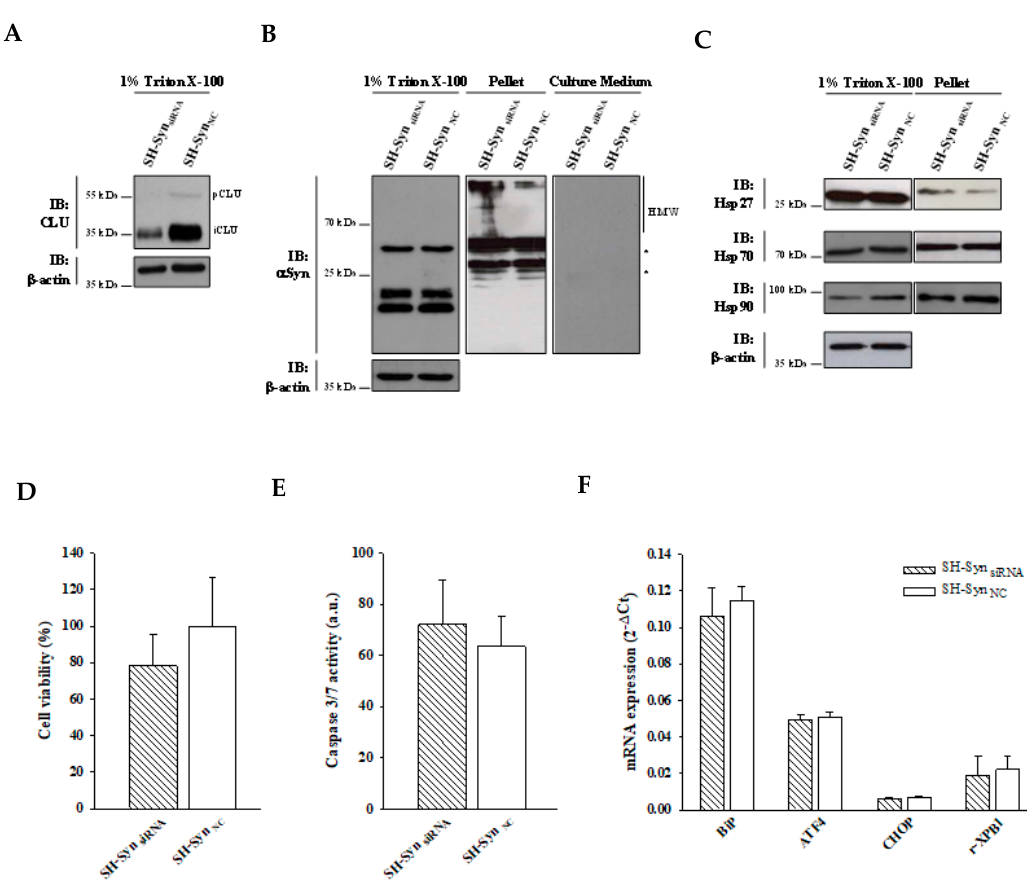
Figure 8. Effects of CLU down-regulation in SH-Syn. ( A ) Detection of CLU in the 1% Triton X-100 soluble fraction of SH-Syn siRNA and SH-Syn NC . Blots are representative of experiments repeated three times. β -actin was used as the loading control. ( B ) Detection of α Syn in the 1% Triton X-100 soluble fraction, in the pellet fraction, and in the culture medium of SH-Syn siRNA and SH-Syn NC . Blots are representative of experiments repeated two times. β -actin was used as the loading control; an asterisk represents non-specific bands. ( C ) Detection of Hsp27, Hsp70, and Hsp90 in the 1% Triton X-100 soluble fraction and in the pellet fraction of SH-Syn siRNA and SH-Syn NC . Blots are representative of experiments repeated three times. β -actin was used as the loading control. ( D ) The cell viability of SH-Syn siRNA and SH-Syn NC by the WST-1 assay. Data are shown as the mean ± SD of two independent experiments, each performed in triplicate. The difference between groups is not statistically significant. ( E ) Analysis of the caspase 3/7 activity in SH-Syn siRNA and SH-Syn NC . Data are presented as the mean ± SD of two independent experiments, each performed in triplicate. The difference between groups is not statistically significant. ( F ) BiP, ATF4, CHOP, and r-XBP1 mRNA quantification by qPCR in SH-Syn siRNA and SH-Syn NC . Data are presented as the mean ± SD of three independent experiments, each performed in duplicate. The difference between groups is not statistically significant.